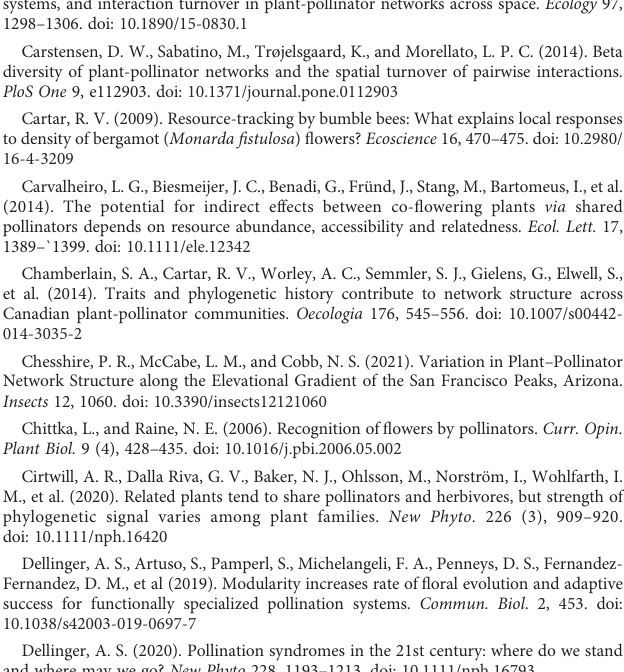
SUPPLEMENTARY FIGURE 5 Differences in fi ve fl oral traits ( fl oral size, fl ower density, fl oral shape, fl oral symmetry and fl oral color) among four different modules in the plant-pollinator network by a Tukey post hoc test using the R package ‘ multcomp ’ (Hothorn et al., 2014). * P < 0.05, ** P < 0.01, *** P < 0.001.